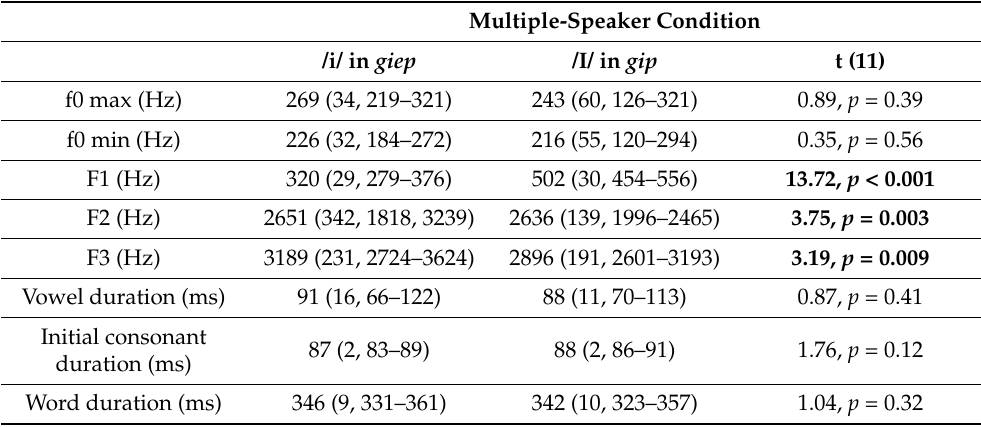
Table 2. Mean (SD, range) f0, F1, F2, F3 and duration of vowels /I/ in [ γ Ip] and /i/ in [ γ ip], and results of the t -tests for comparison of each of these